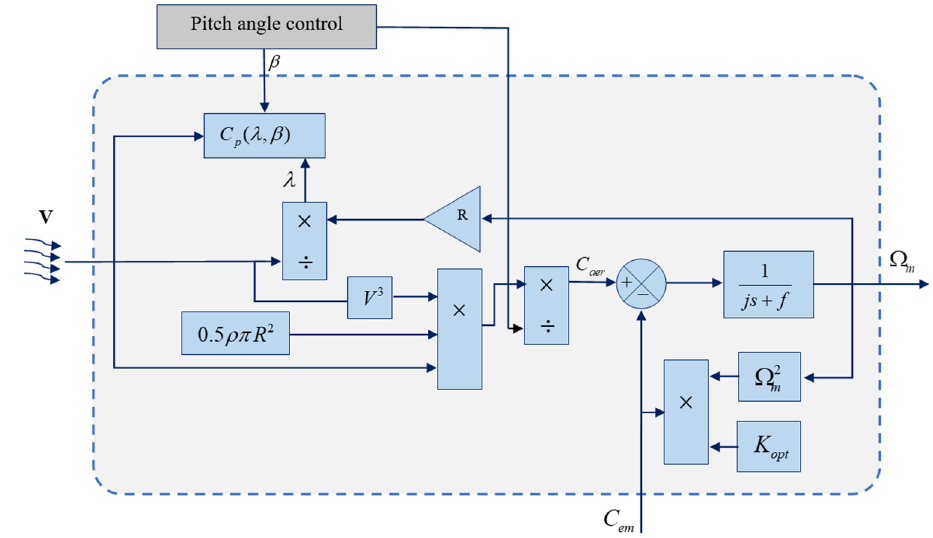
Figure 2. Diagram of wind turbine model.